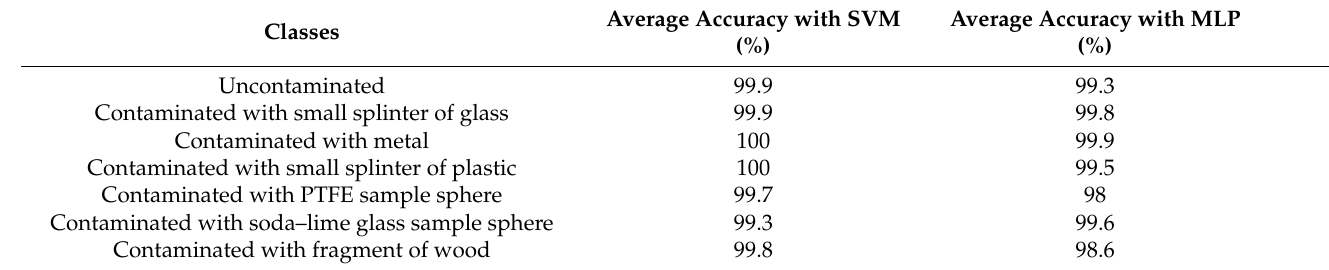
Figure 14. The plot of the misclassified terms FP and FN of the confusion matrices for each con- taminated class alone. The results were obtained by the MLP algorithm trained on the Complex nature dataset. Table 6. The average performance accuracy of the two classifiers with the Complex nature